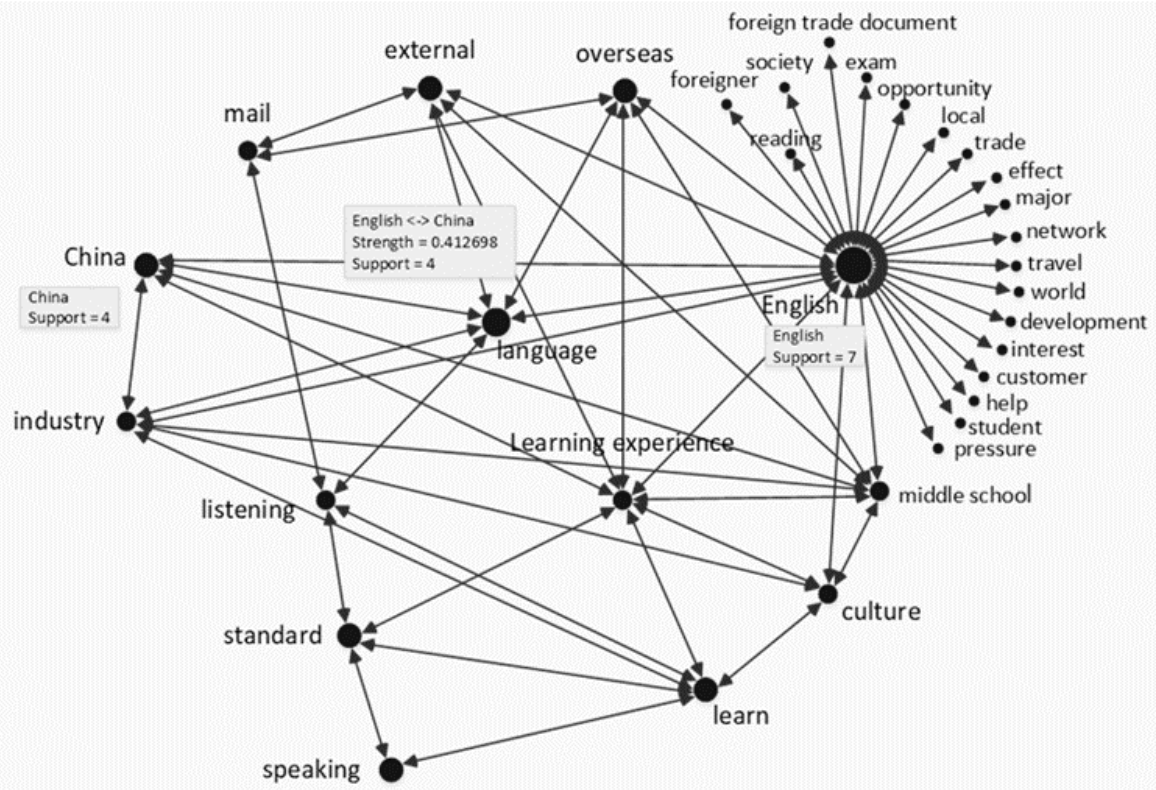
Figure 1. English majors social network analysis.